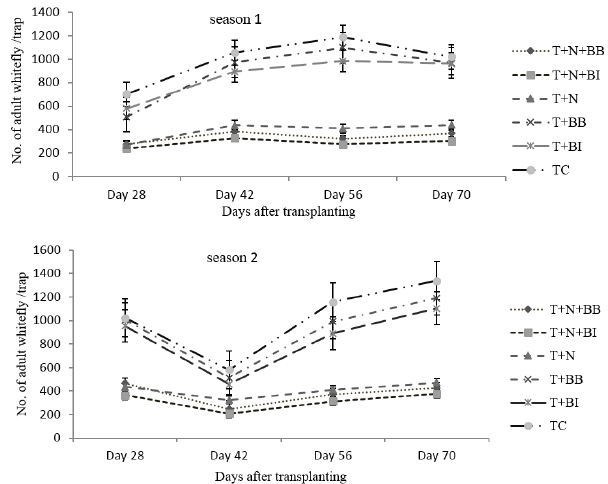
Figure 3. Effects of agronet cover and companion planting with basil on number of adult B. tabaci on